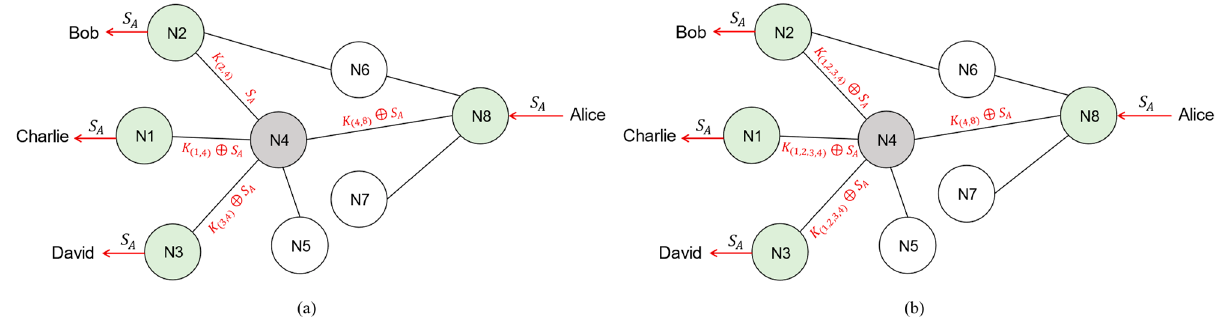
Figure 4. Schematic diagram of transmitting a session key, in which ( a ) presents the schematic diagram of transmitting session key in P2P method and ( b ) the schematic diagram of transmitting session key in point-to-multipoint (P2M) method.